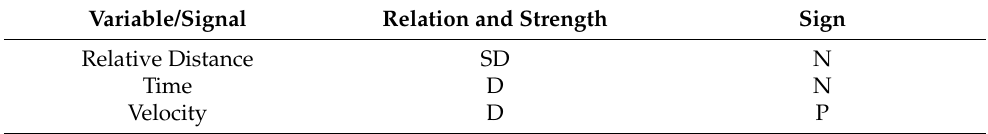
Table 4. Domain knowledge for reward shaping.